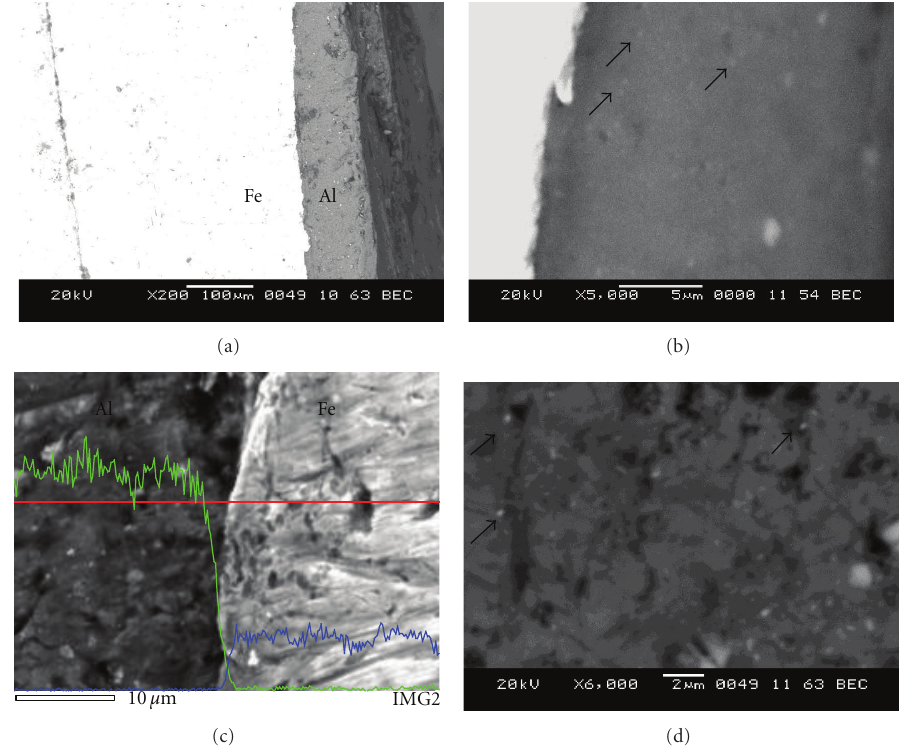
Figure 4: (a) Cross-sectional microscopy showing a uniform deposition. (b) Nature of Fe-Al deposit interface. (c) Smooth and thin interface between aluminium and iron. (d) Fine Fe particles embedded in deposited Al.